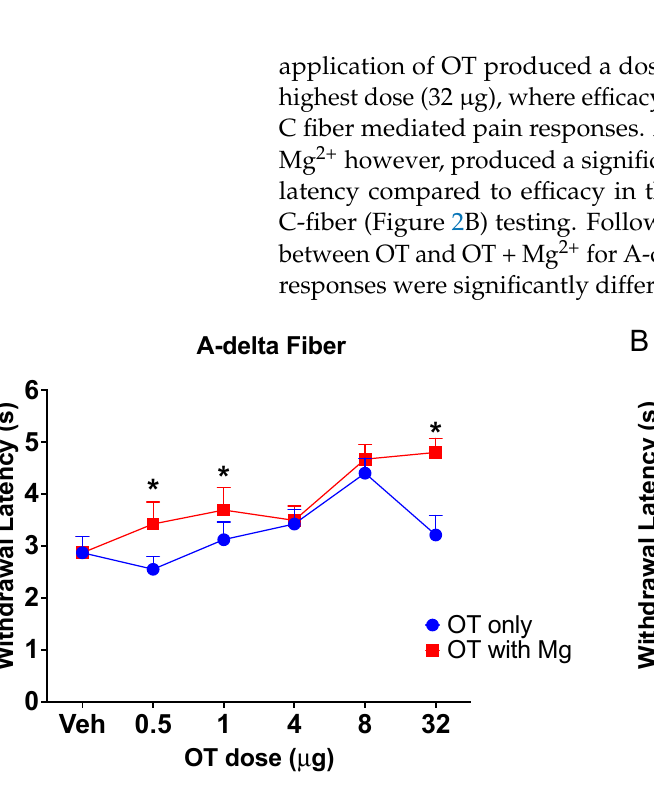
Figure 2. Effect of the addition of Mg 2+ on intranasal OT-induced craniofacial analgesia. For both A-delta ( A ) and C fiber ( B ) mediated withdrawal responses to noxious heat stimulation of the cheek of pre-inflamed rats, intranasally applied OT produced a dose-dependent analgesic effect as evidenced by significant ( p < 0.05, ANOVA) increases in withdrawal latency at the 60 min time point after administration, n = 10. However, the addition of 300 mM Mg 2+ to the treatment significantly increased OT analgesia for both stimulus types ( p < 0.05). Subsequent pairwise comparisons indicated significant (* = p < 0.05) differences from OT alone for OT plus Mg 2+ for A-delta testing at OT doses of 0.5, 1.0, and 32 µg ( p < 0.05); C-fiber responses were significantly different (* = p < 0.05) at 0.5, 4.0, 8.0, and 32 µg OT. Interestingly, while the efficacy of the highest OT dose (32 µg) demonstrated a decrease in efficacy when compared to lower doses, this dose-response inversion was prevented by the addition of Mg 2+